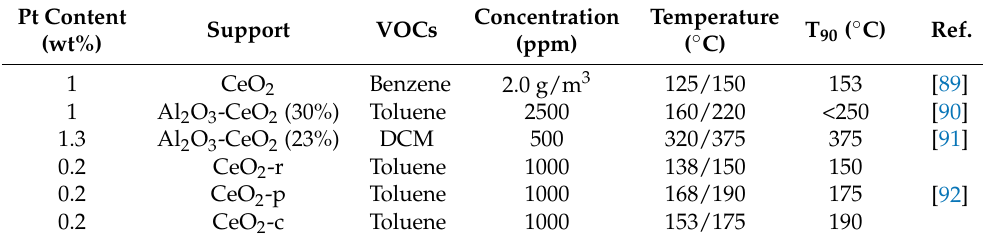
Table 5. Comparison of Pt-based catalysts on various supports for VOC oxidation.